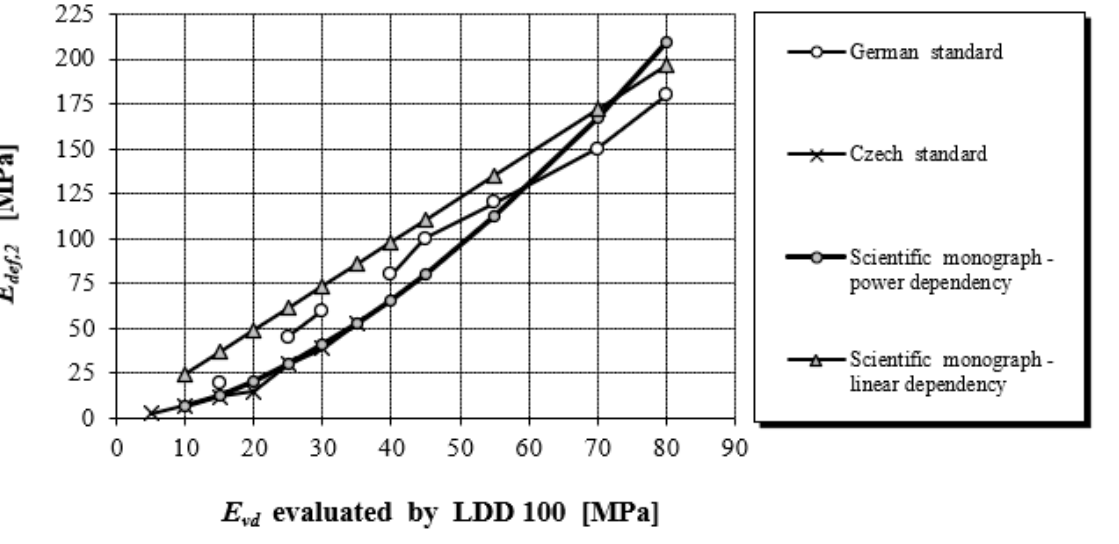
Figure 7. Comparison of objectified correlation dependencies with German and Czech conversion values.